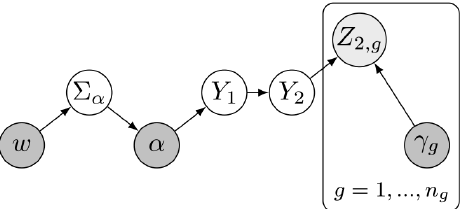
Figure 3. Graphical model summarizing the relationship between the unknown parameters that are optimized in the inversion (dark grey, bottom row), intermediate variables (white, middle row), and the atmospheric mole fraction grouped by station (light grey, top row). The arrows represent the statistical dependence between the